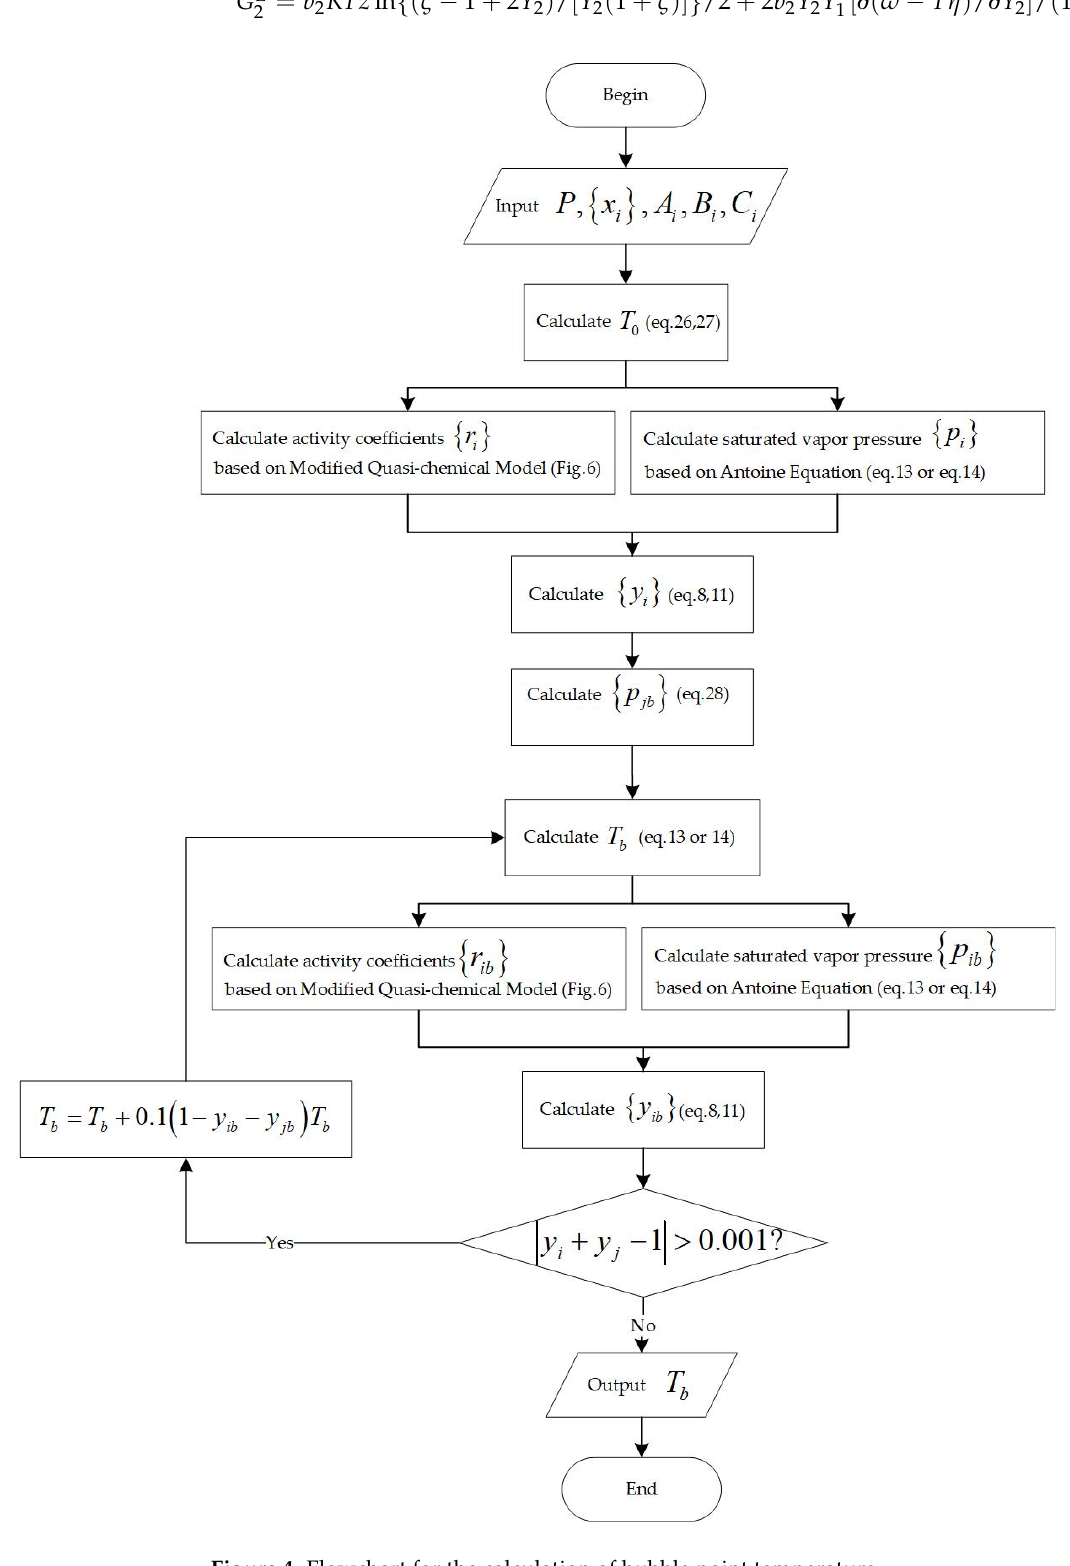
Figure 4. Flowchart for the calculation of bubble point temperature.